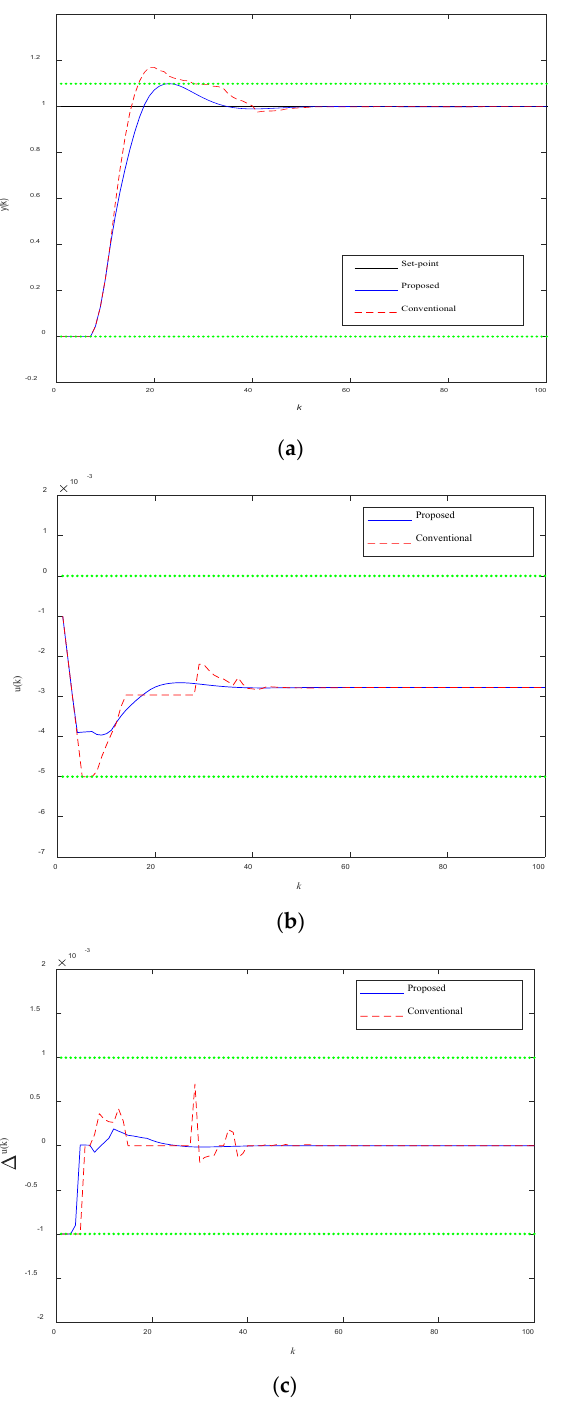
Figure 4. ( a ) Output responses under case 1 and loose constraints; ( b ) input responses under case 1 and loose constraints; ( c ) input increment responses under case 1 and loose constraints.